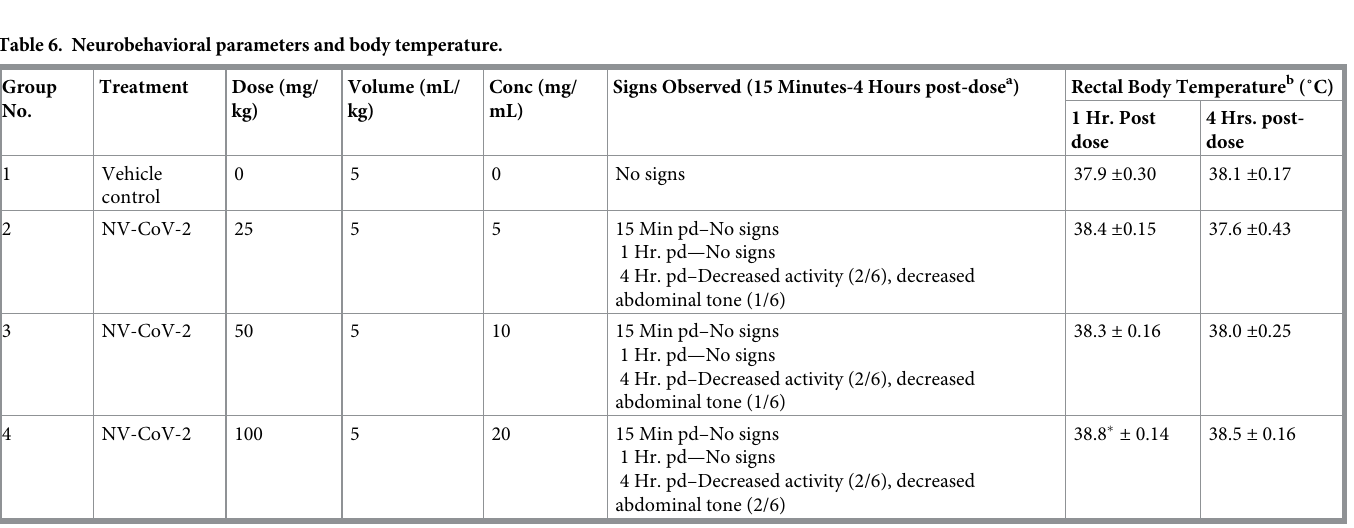
Table 6. Neurobehavioral parameters and body temperature. Group